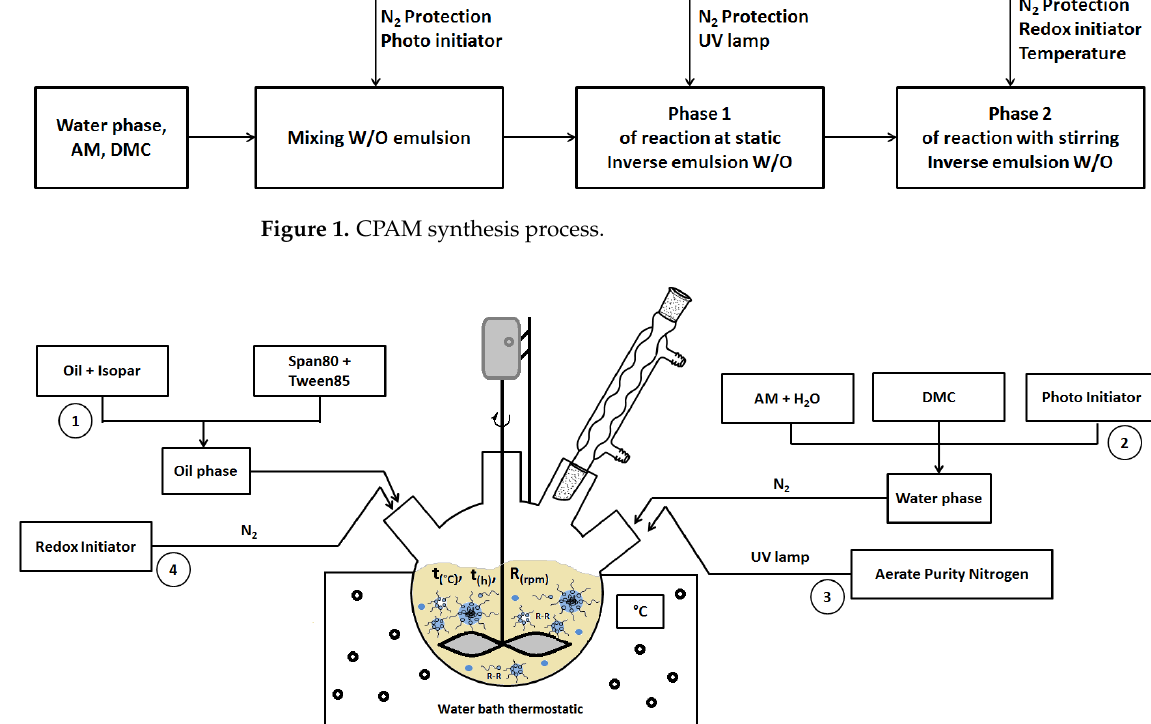
Figure 2. Device diagram.